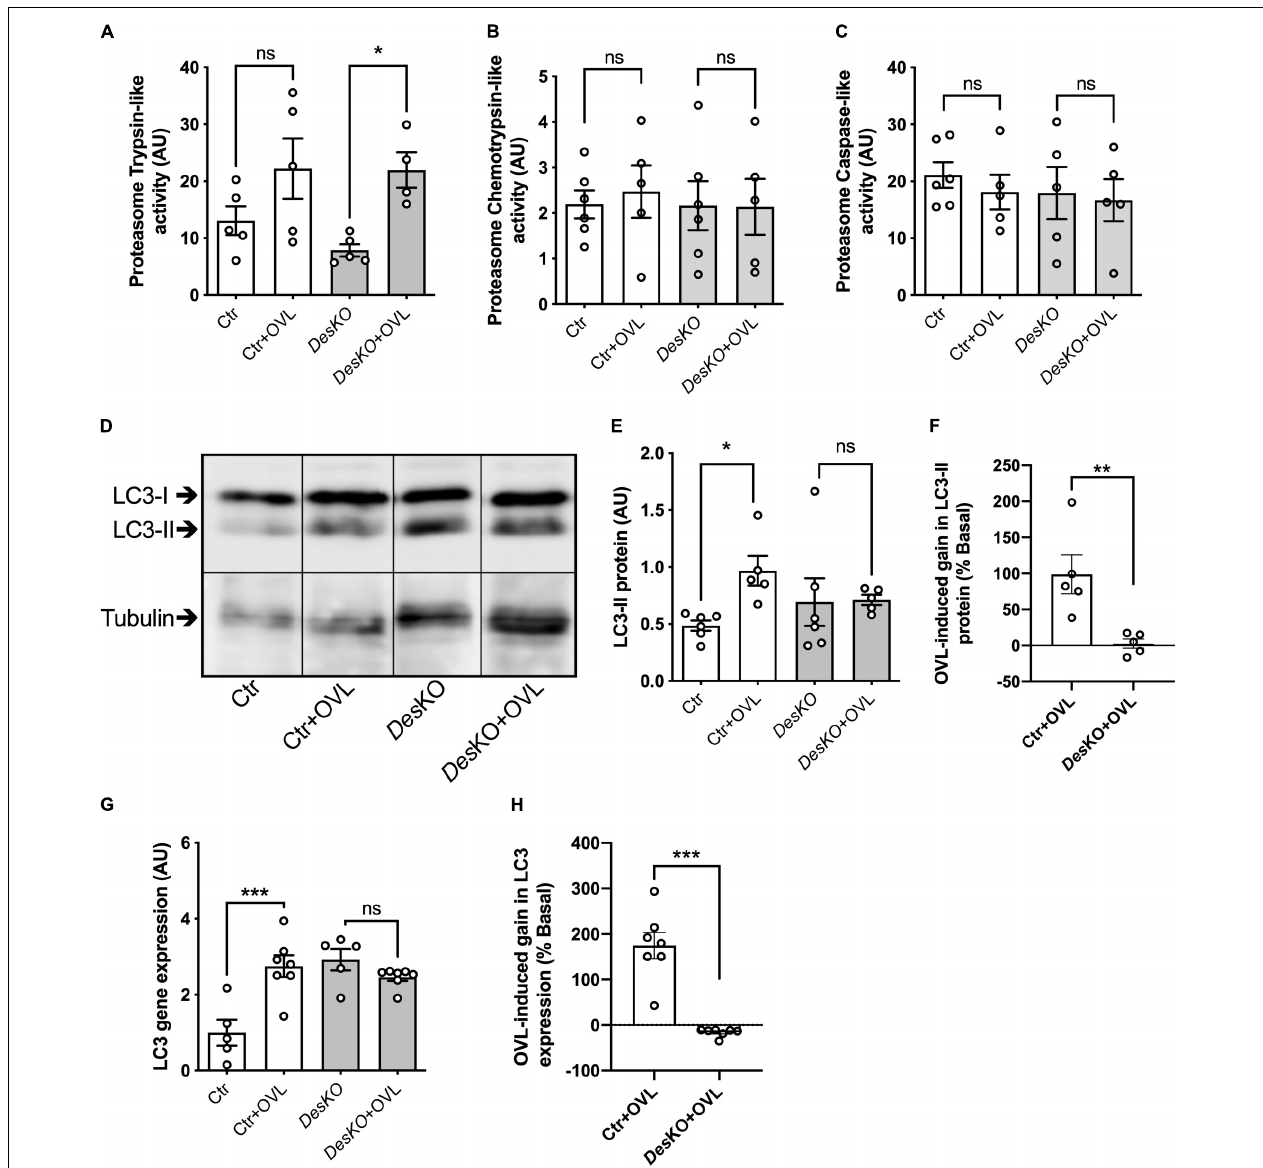
FIGURE 7 | Proteostasis pathways are disturbed in DesKO after OVL. The trypsin-like activity (A) , chymotrypsin-like activity (B) and caspase-like activity (C) of proteasome were measured in both genotype (Ctr and Des KO) in basal condition or after 1 month of OVL. LC3-II protein (D–F) and LC3 gene expression (G,H) were quantified in both genotype (Ctr and Des KO) in basal condition or after 1 month of OVL. Data are given as means ± SEM. Des KO, Desmin knock-out mice; Ctr, Control mice; OVL, mechanical overloading. ns : non-significant, * p < 0.05, ** p < 0.01, *** p <